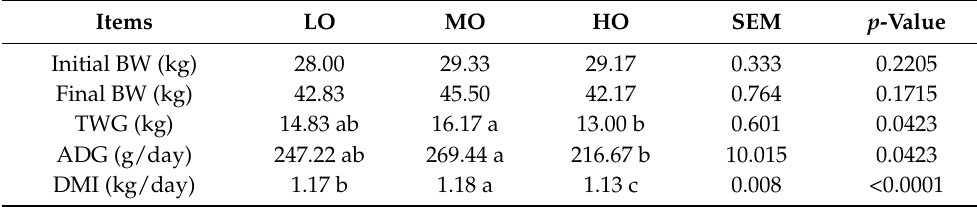
Table 2. Growth performance of lambs fed fermented total mixed rations with different ratio of alfalfa and oat.